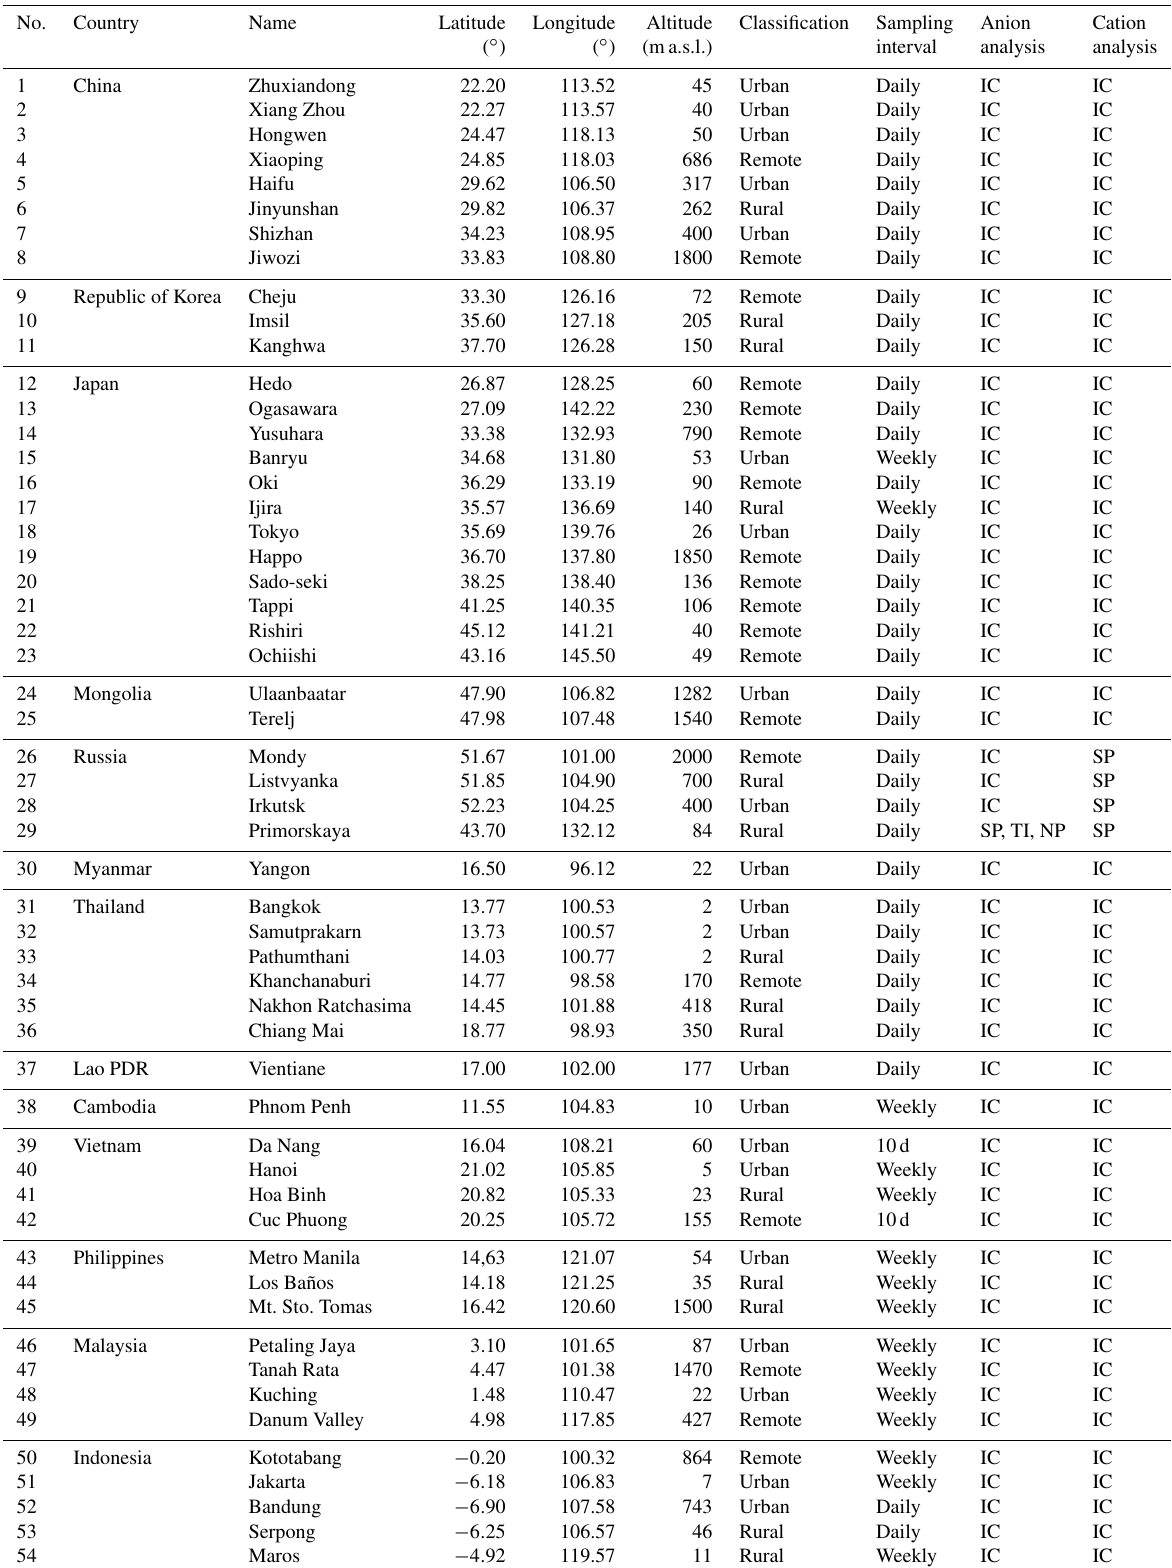
Table 2. Locations and methodology for 54 EANET observation sites.